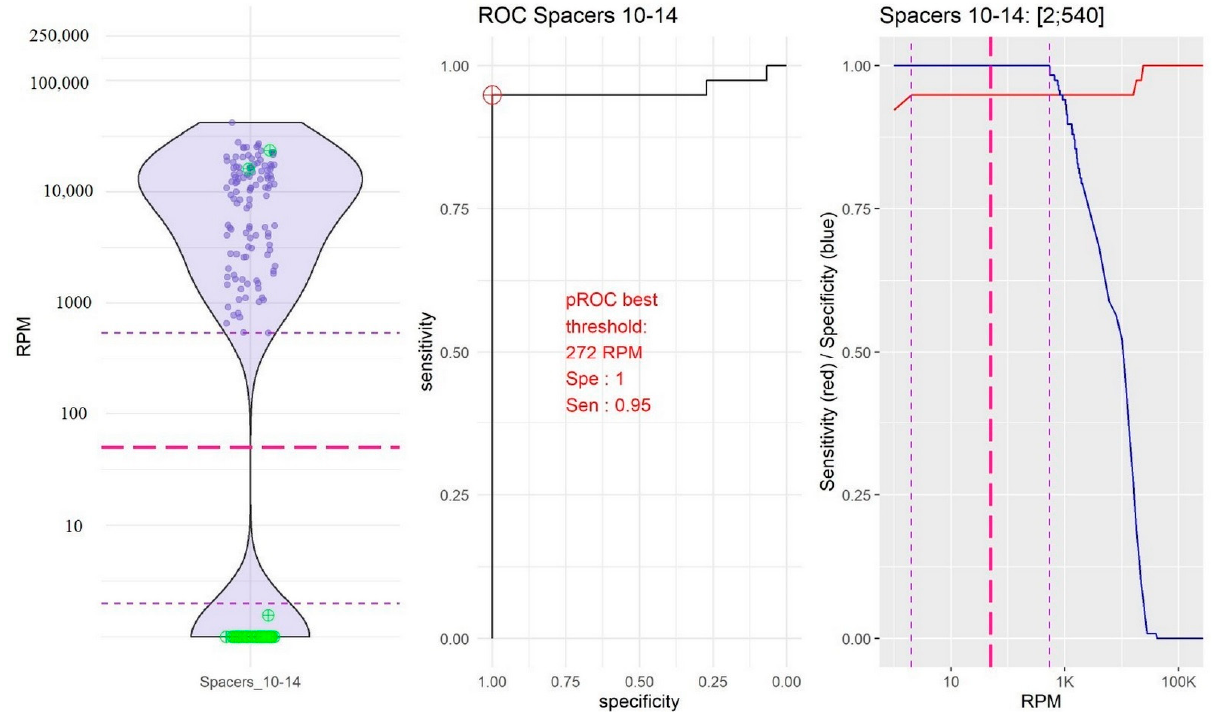
Figure 2. Determination of the reads per million (RPM) threshold for spacers 10 and 14. On the left: Distribution in the form of a violin plot of spacers 10 and 14 RPM. Purple circles represent the “present” spacers according to the membrane-based spoligotyping. Green circles represent the “absent” spacers according to the membrane-based spoligotyping. Dotted red line: RPM threshold choice (50 RPM). In the middle: Receiver operating characteristic (ROC) curve for spacers 10 and 14. Red circle represents the best RPM threshold. On the right: Sensibility (red line) and specificity (blue line) compared to the membrane-based spoligotyping according to the variable RPM threshold. Dotted purple line: RPM thresholds between which the sensitivity and the specificity are maximized. Dotted red line: RPM threshold choice (50 RPM).